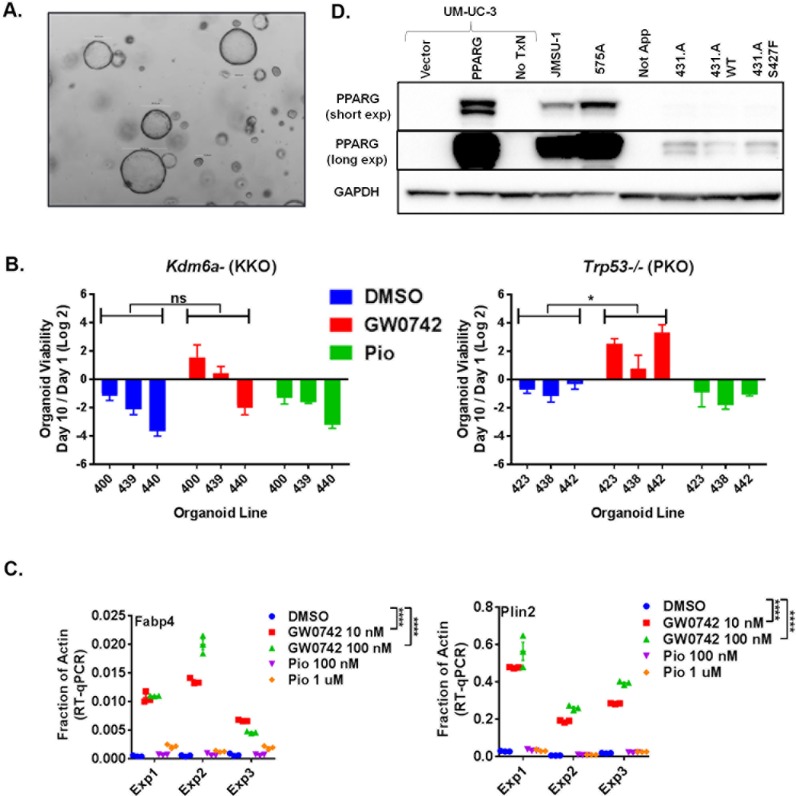
(A) Wild-type urothelial organoids grown for 3 weeks in standard organoid media and imaged with low-power (4X) phase contrast bright-field microscopy. (B) CellTiter-glo growth assay in media without EGF performed identically to those in Figure 4A and Figure 4B, but with organoids generated from mice with singly floxed Trp53 or Kdm6a. Statistical comparisons are by unpaired t test. (C) Aggregated RT-qPCR from three distinct experiments as described in Figure 4D with each data point from each experiment plotted with mean indicated. Statistical comparisons are by two-way ANOVA (Repeated Measures, GraphPad Prism). (D) PPARG western blot of indicated cell lines. PPARG transfected UM-UC-3 included as a positive control. Equivalent protein mass from whole cell lysates were loaded into each well.